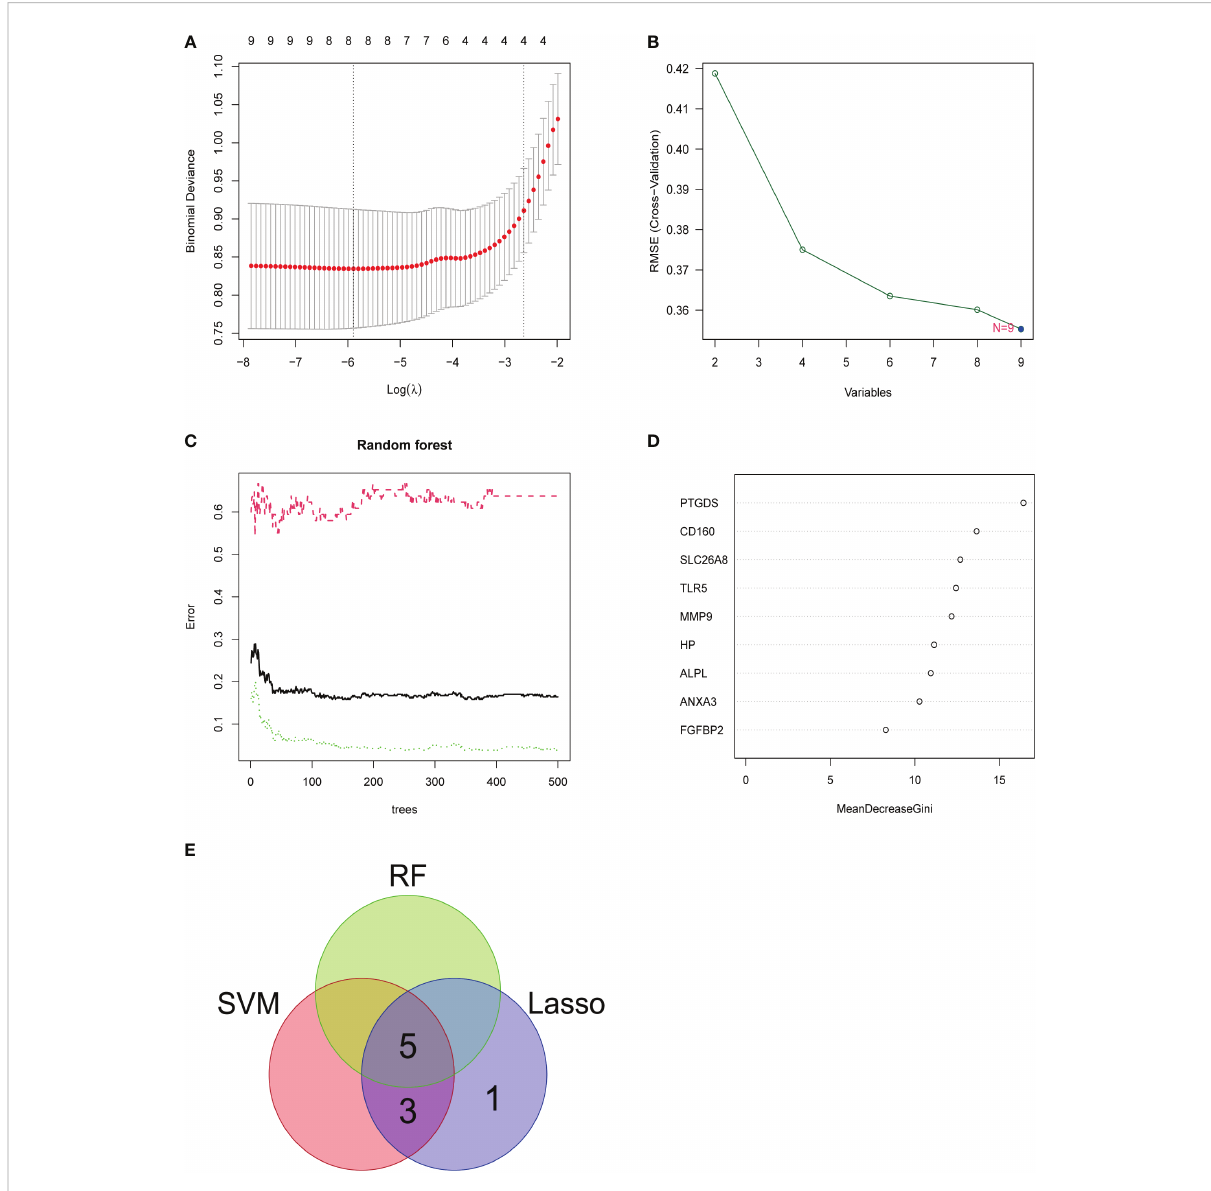
FIGURE 3 LASSO, SVM-RFE, and random forest were used for feature selection. (A) LASSO coef fi cient pro fi les of eight genes that initially met the prognostic criteria. (B) Biomarker selection map based on the support vector machine recursive feature elimination (SVM-RFE) algorithm. (C) Random forest model. (D) Random forest MeanDecreaseGini assessment. (E) Venn diagram shows the fi ve diagnostic markers shared by the three